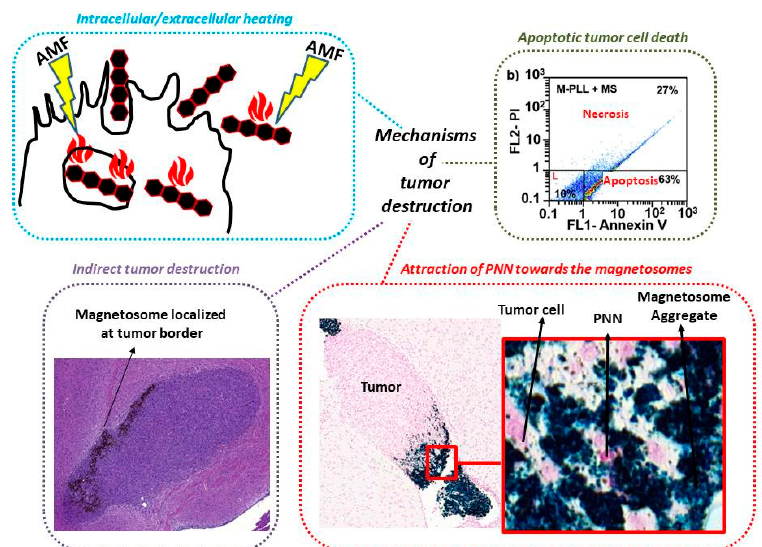
Figure 4. Schematic diagram presenting the possible mechanism of actions associated with anti-tumor activity, i.e.,: (i) localized heat produced at magnetosome location, either inside or outside cells depending on whether magnetosomes internalize in tumor cells or remain localized outside these cells, (ii) an apoptotic mechanism as highlighted when magnetosomes were brought into contact with U87-Luc cells and exposed to one magnetic session, (iii) mechanism of indirect tumor destruction involving magnetosomes covering the border of GBM tumor, and (iv) the attraction of immune cells (PNN) by the magnetosomes since PNN were observed near the magnetosomes in GBM tumors following a magnetic session although a direct link between the presence of PNN and the anti-tumor activity was not established.